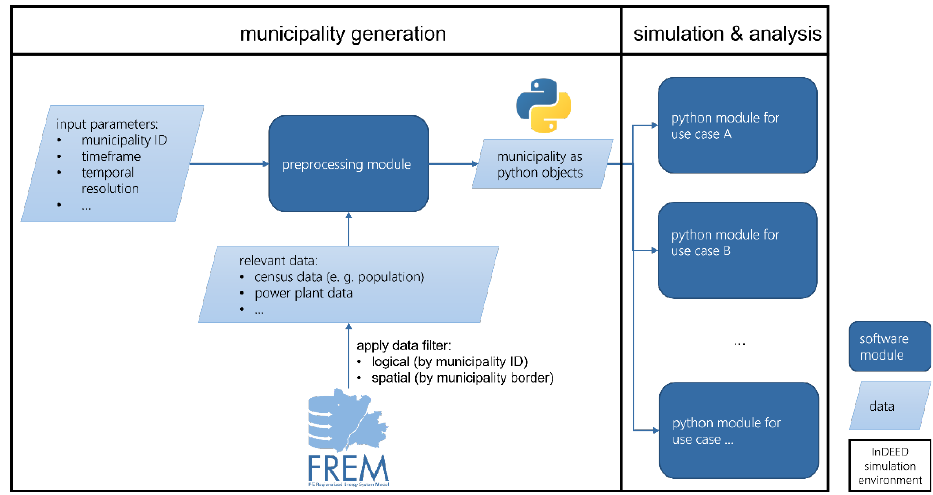
Figure 10. High-level structure of the simulation framework.